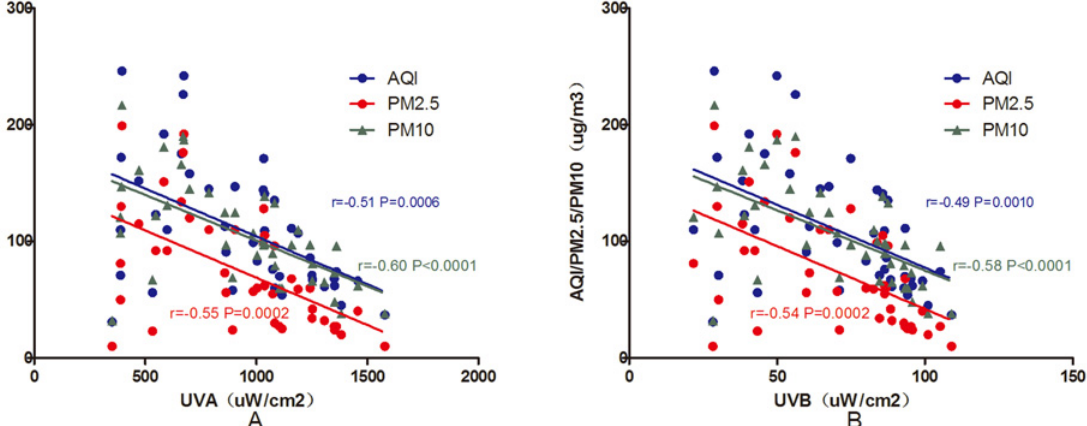
Fig 7. The relationship between UVA and UVB intensity and air quality parameters (AQI, PM2.5, and PM10). A: Pearson ’ s correlation analysis demonstrated a significant negative correlation between UVA intensity and air quality parameters (AQI: r = -0.51, P = 0.0006; PM2.5: r = -0.55, P = 0.0002; and PM10: r = -0.60, P < 0.0001). B: Pearson ’ s correlation analysis revealed a significant negative correlation between UVB intensity and air quality parameters (AQI: r = -0.49, P = 0.0010; PM2.5: r = -0.54, P = 0.0002; and PM10: r = -0.58, P < 0.0001).